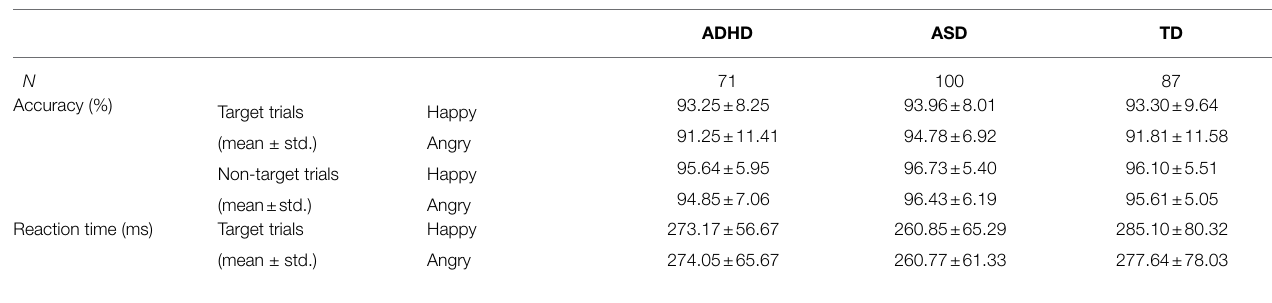
TABLE 2 | Task accuracy and reaction time.